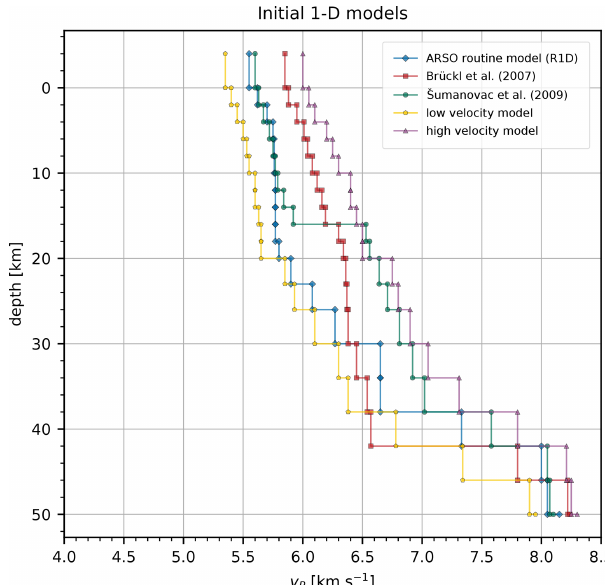
Figure 2. Initial 1-D models derived from the independent studies (blue, red, green). The low-velocity (yellow) and high-velocity (pur- ple) models roughly envelop the three initial models derived from the independent studies and are used to further sample the solution